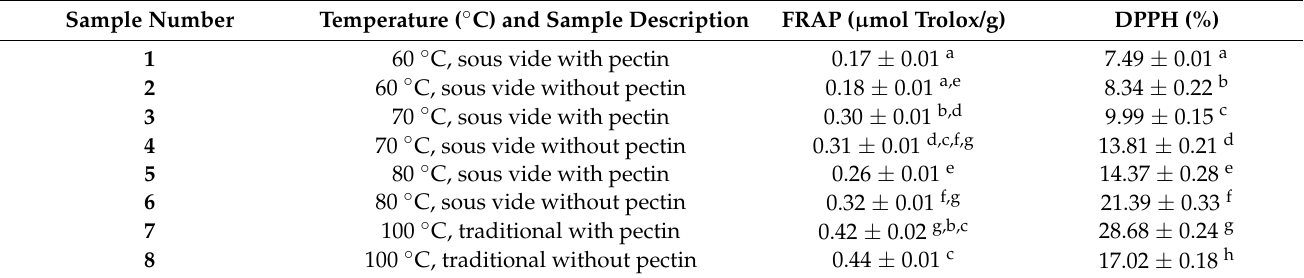
Table 2. Influence of cooking on the value of antioxidant activity of medlar jam prepared by the sous vide method and the classic cooking method using the FRAP and DPPH